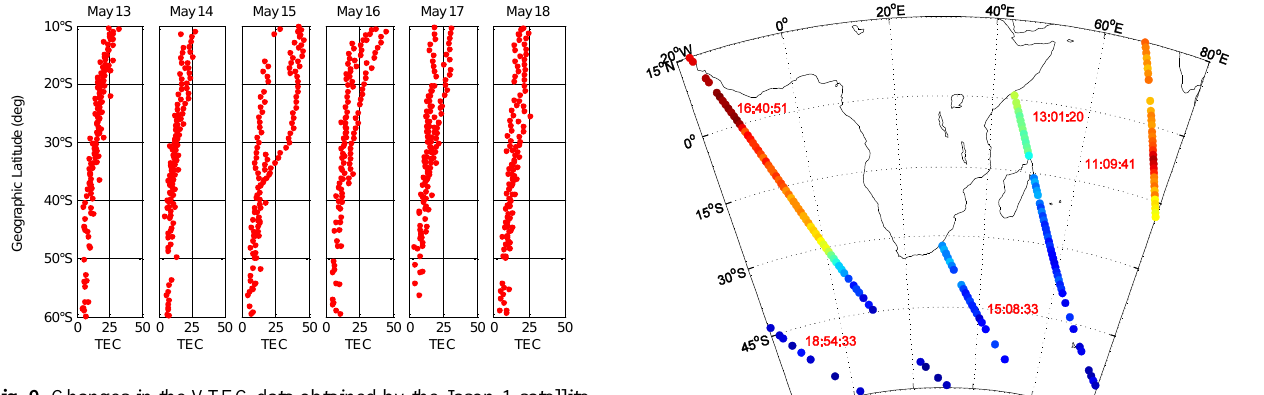
in the descending orbit from 13 to 18 May.